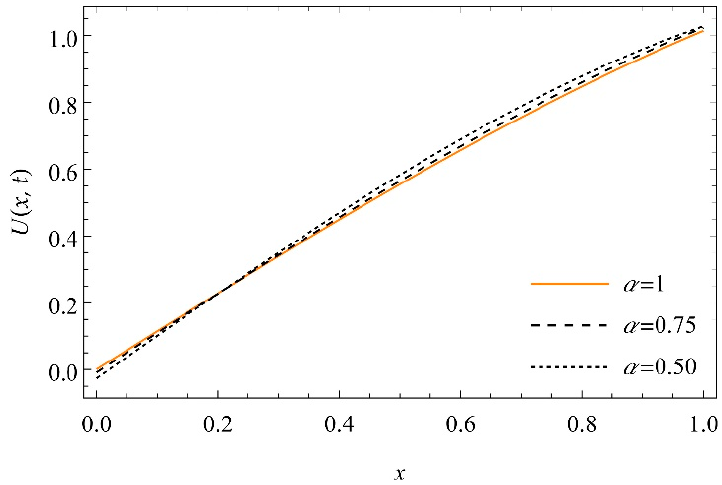
Figure 16. The graph of U ( x , t ) versus depth x at n = 1, t = 0.1, and for α = 1, 0.75, 0.50 for